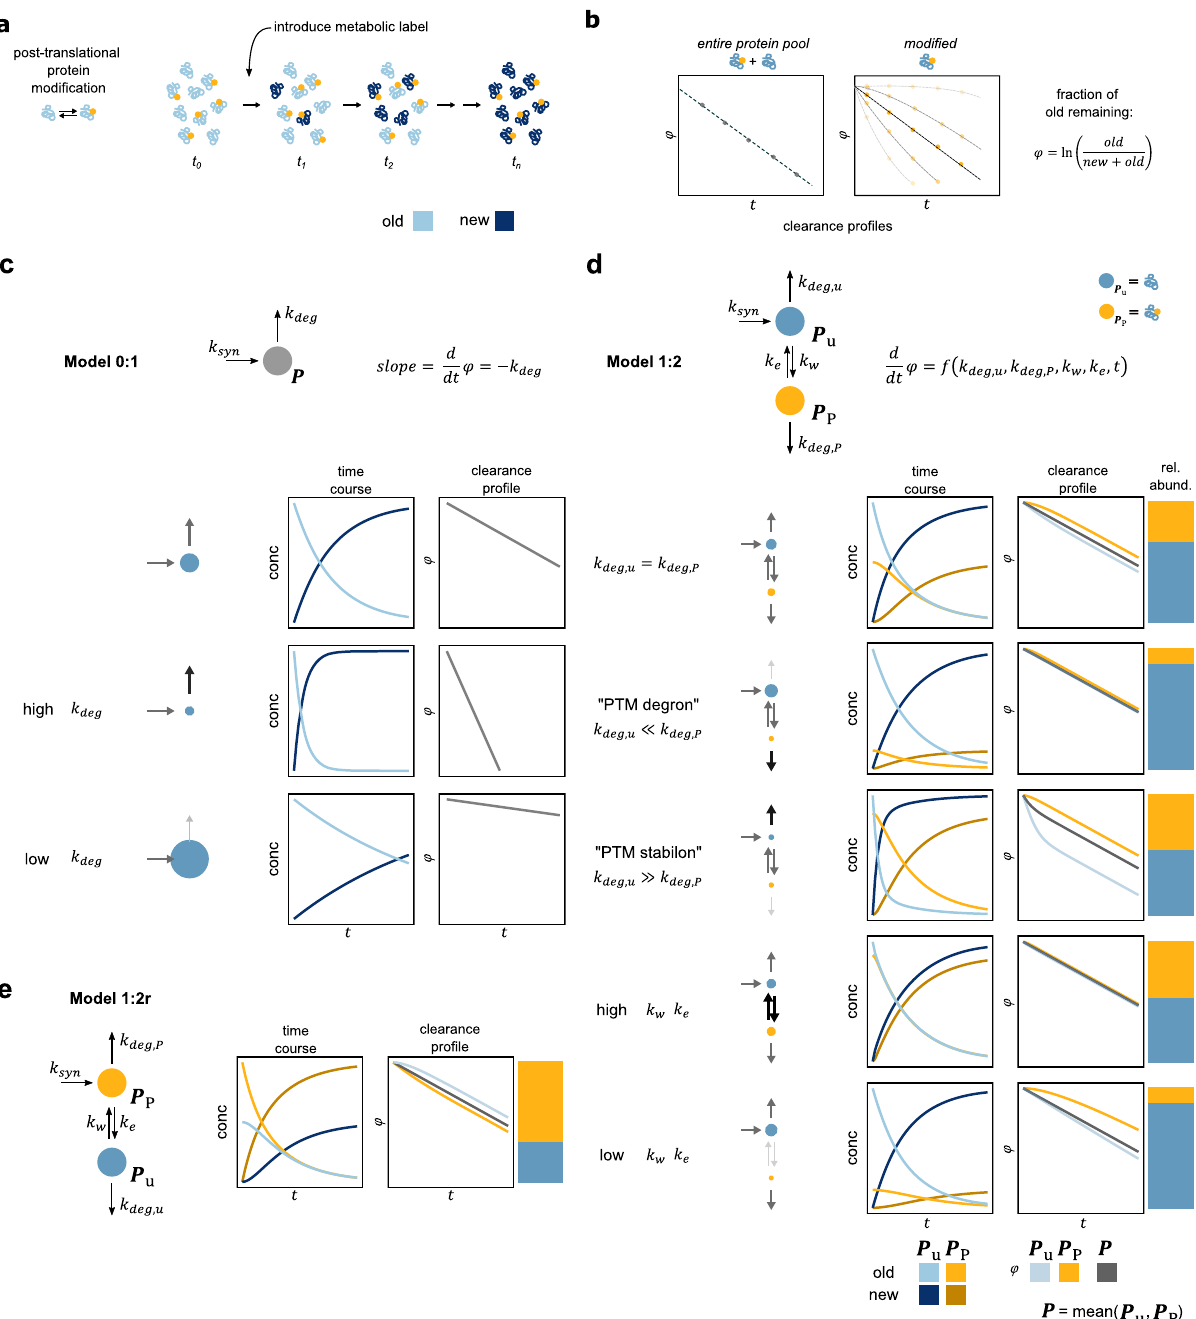
re fl ectthemagnitudeoftherateconstant.Thesizeofthecirclere fl ectsthesteady- state amount of the species. d Two-species model (Model 1:2) including protein modi fi cation. The slopes of the clearance pro fi les are complex functions of the model parameters (all but the synthesis rate k syn ), and change over time (see Supplementary Note 1 for full analytical description). In Model 1:2 clearance of the modi fi edspecies P P canneverbefasterthantheclearanceoftheentireproteinpool P . Parameter combinations with distinct biological interpretation have practically indistinguishable clearance pro fi les. e Alternative (reverse, r) two-species model, Model 1:2r, in which a protein is synthesized as a modi fi ed species, allows faster clearance of the modi fi ed species P P compared to the entire protein pool P . The relative orderof clearancepro fi lesisde fi ned bythe orderof species(or “ wiring ” of the modi fi cation network) during a protein ’ s lifetime. See also https://apps.embl. de/pptop for an interactive web application of the models.